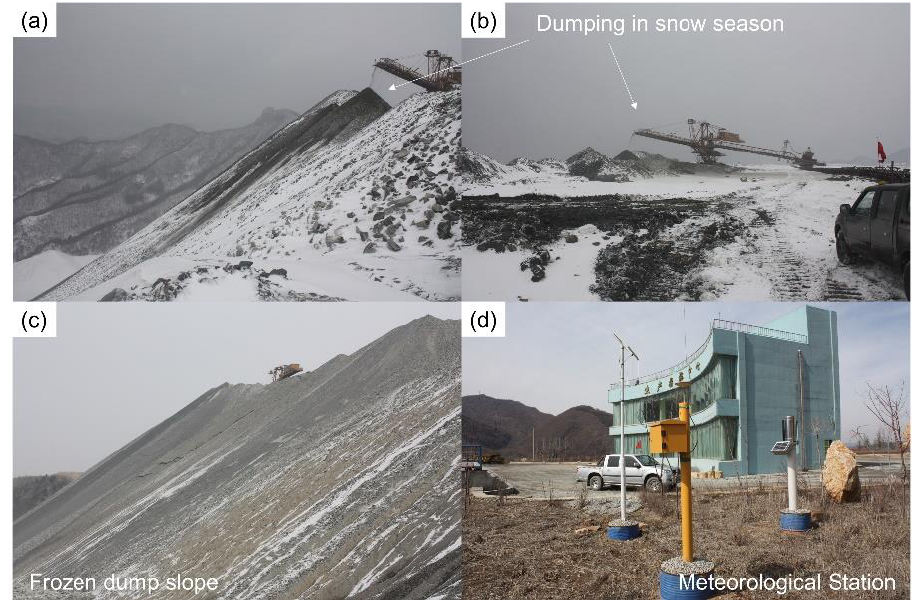
Figure 8. Continuous and intensive dumping in snow season: ( a – c ) dumping in snow season; ( d ) meteorological monitoring station.